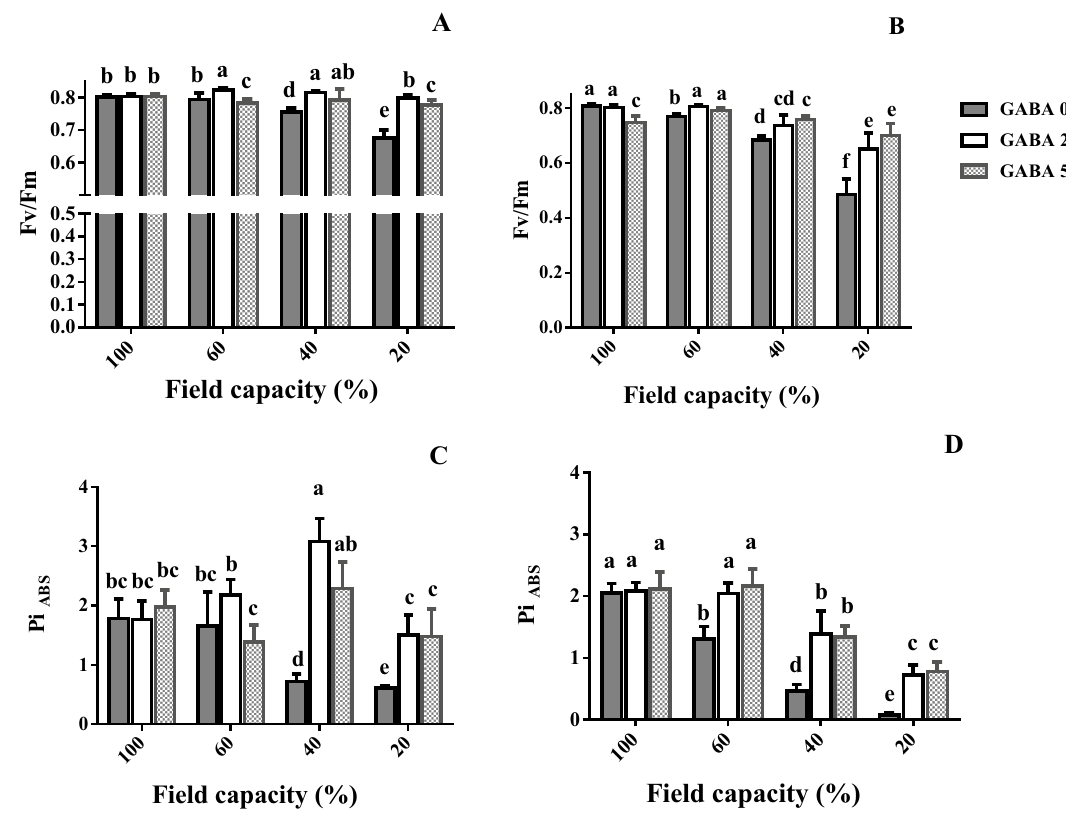
Figure 9. Leaf maximum quantum efficiency of photosystem II (F v /F m ; A , B ) and performance index on absorption basis (Pi ABS ; C , D ) of cv. Arman (tolerant; left panels) and cv. Azad (sensitive; right panels) chickpea plants receiving exogenous application of γ-aminobutyric acid (GABA) at different concentrations (0, 25 and 50 μM) under different watering levels (100, 60, 40 and 20% field capacity) during cultivation. Within each insert, different letters indicate significant differences. Error bars indicate SEM (n =